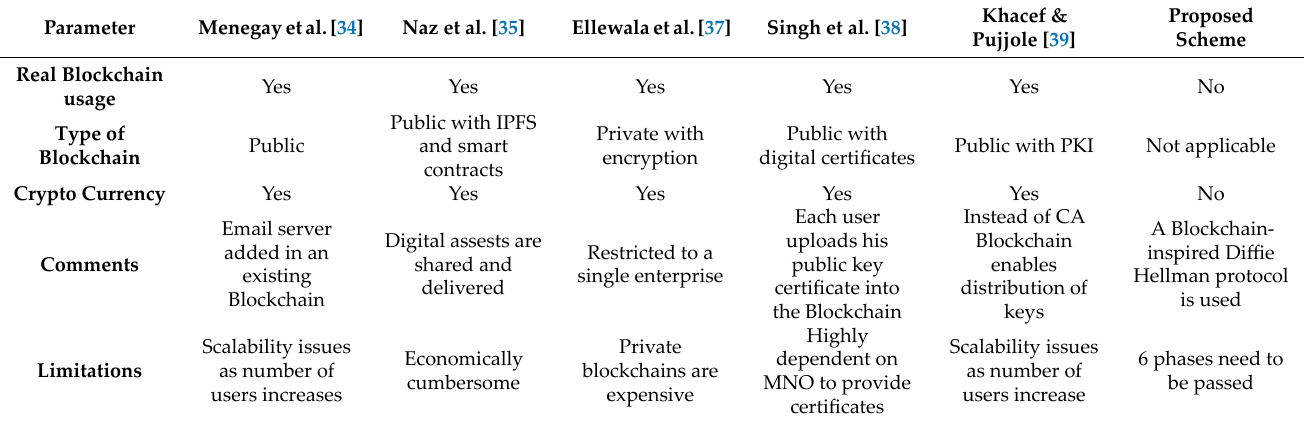
Table 15. Comparison of Proposed Cipher Transmission Scheme with Existing Similar